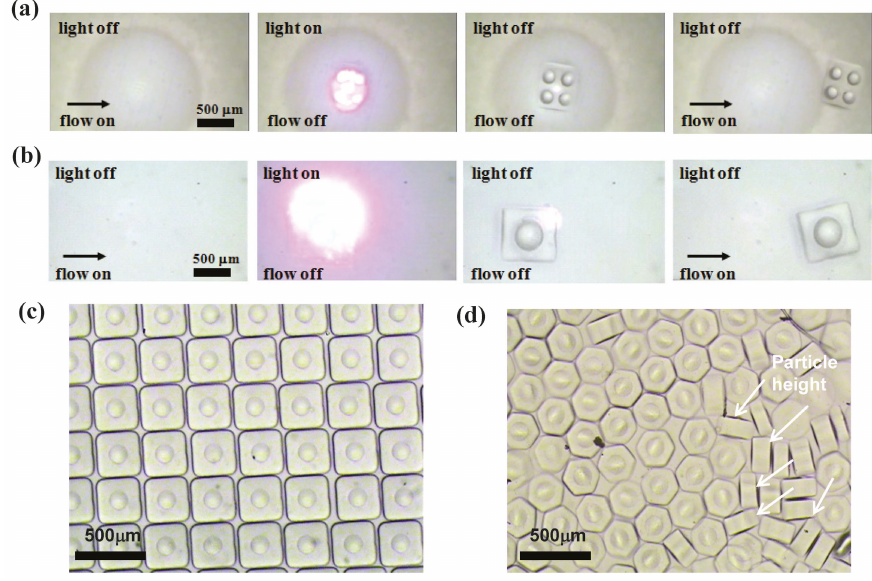
Figure 3. Images showing the four-step process for producing the suspended ( a ) 2 × 2 microlens array and ( b ) single microlens in a PDMS microchannel via the EFM-3D gray mask filled with dye oils at C dye oil = 0.015 ( w / v ) and operated without applied voltages. The EFM-3D mask was set at the field-stop plane of the microscope equipped with a 4× objective. A shadow mask placed onto the EFM-3D mask defines the shape and size of the substrate of the produced microlens structures. The suspended microlens structures with ( c ) square and ( d ) hexagonal substrates were flushed downstream and collected in the reservoir of the microchannel. Some of the polymerized microlens structures have turned on their sides showing the height of the microlens as shown by white arrows in ( d